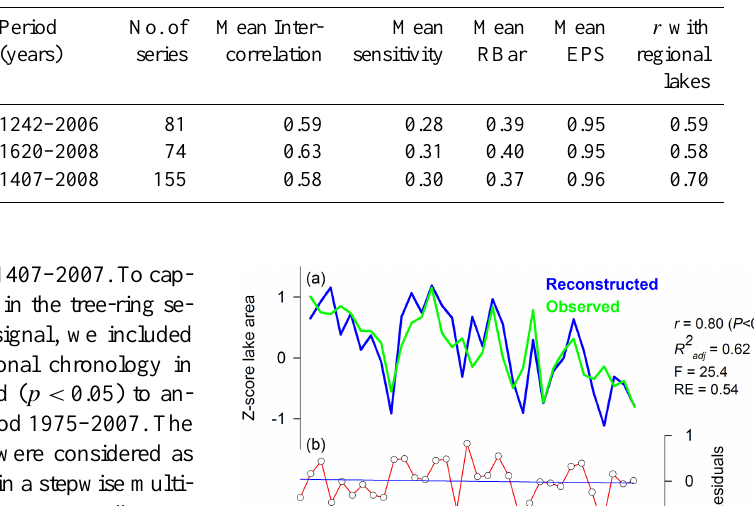
Table 1. Geographical location and statistics of the Polylepis tarapacana ring width chronologies. Mean RBar and mean EPS were averaged over chronology periods including > 10 tree-ring series.